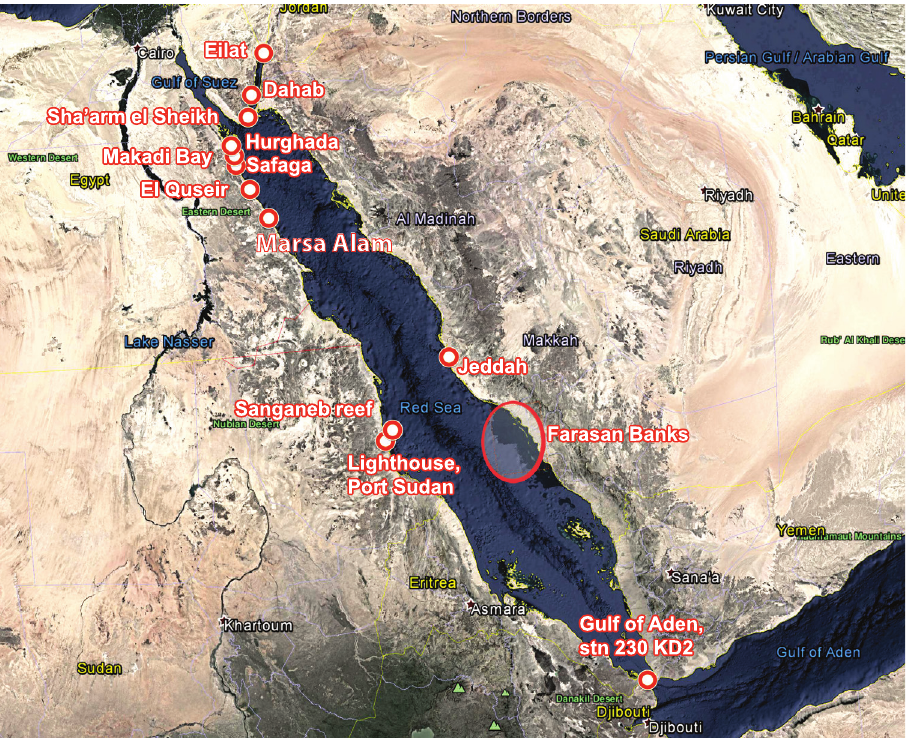
Map 1. Map of the Red Sea showing all the collecting and photograph sites listed in this